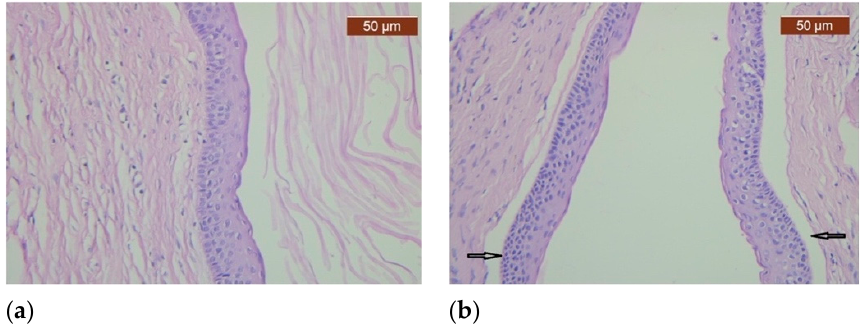
Figure 3. Histopathological examination of the specimen shows a cystic space delineated by 6–8-layers-thick squamous epithelium with basal layer arranged in palisaded manner. ( a ) The cyst wall’s photomicrograph shows that the cyst’s inner surface is lined by squamous epithelium with orthokeratinization; ( b ) The epithelium and connective tissue are focally detached (arrows).